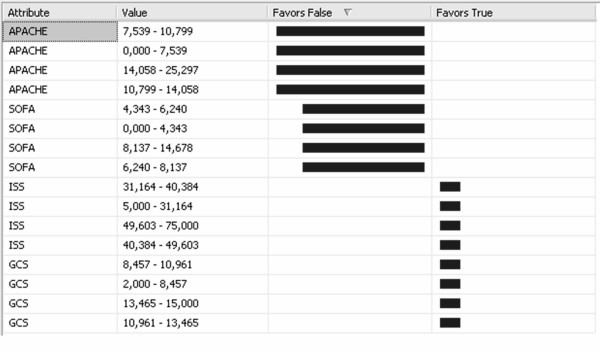
The NNM results.